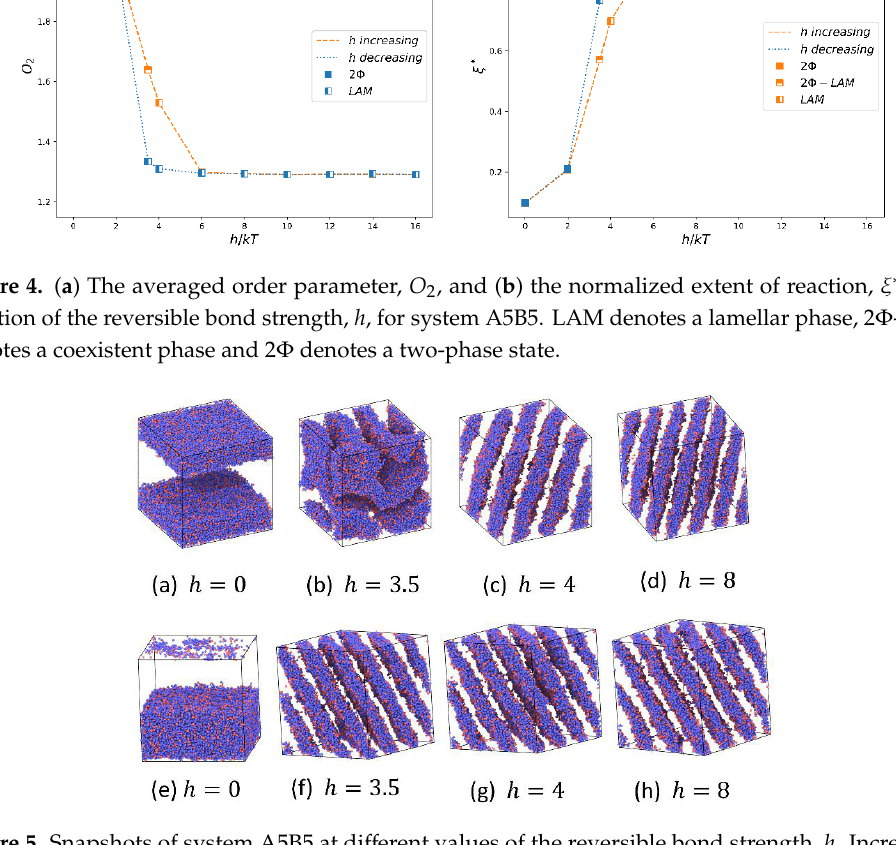
Figure 5. Snapshots of system A5B5 at different values of the reversible bond strength, ℎ . Increasing ℎ process: ( a – d ); decreasing ℎ process: ( e – h ). Red color denotes reactive A particles and blue color denotes nonreactive A particles. For clarity, B particles are not shown. All following phase separation morphology snapshots use the same settings.